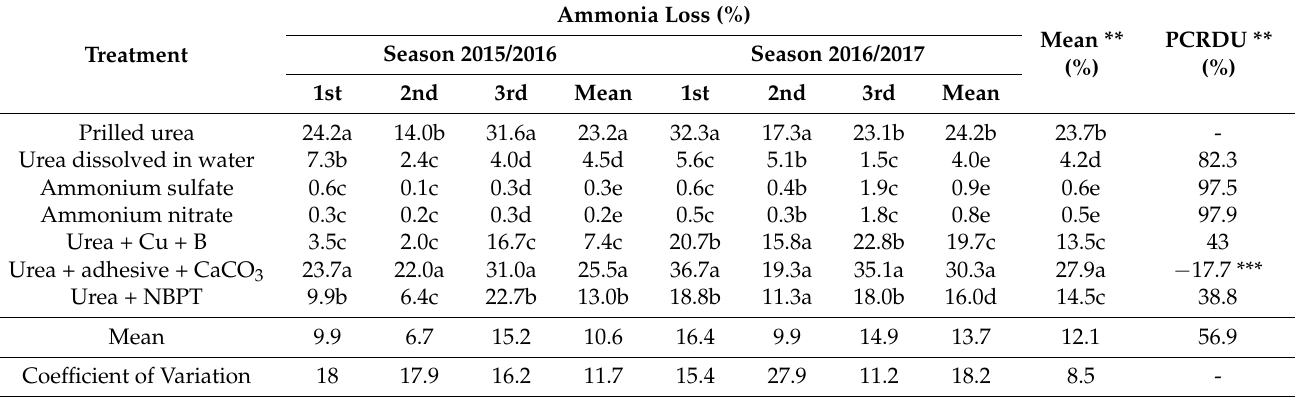
Table 3. Mean accumulated losses of ammonia (% of applied N), for conventional and stabilized N fertilizers, in three fertilizations in the coffee plantation, during the 2015/2016 and 2016/2017 crop